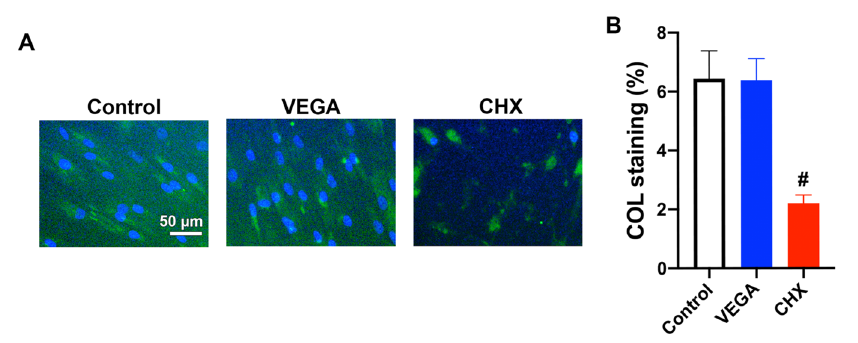
Figure 5. Immunofluorescent collagen 1 (COL1) staining of HGF-1 cells treated in 1% of either VEGA or CHX at 7 days. ( A ) The merged fluorescent images of COL1 staining (green) with DAPI staining (blue). ( B ) Quantified values of COL staining (n = 9, # denotes significantly lower than other modalities, p < 0.05).